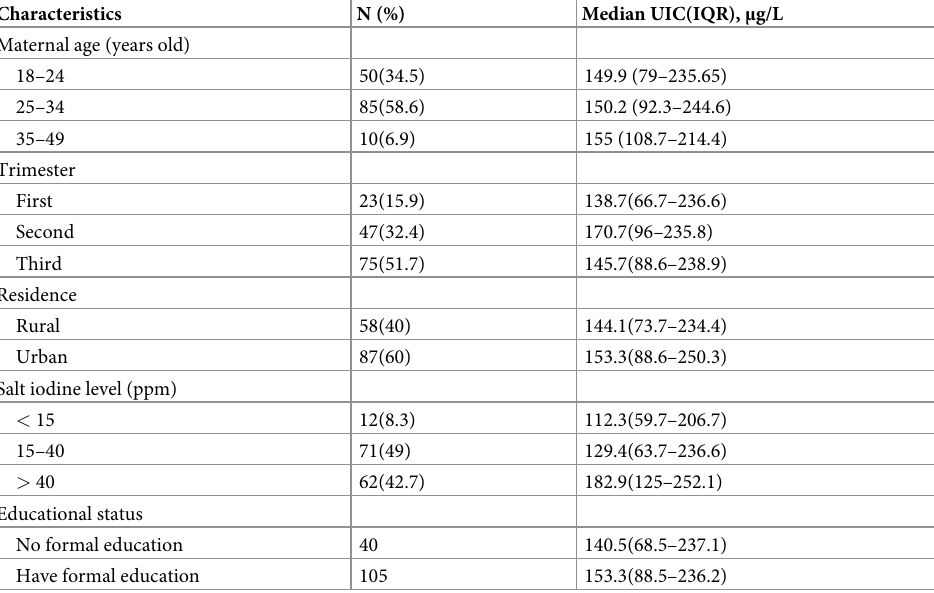
Table 3. Median UIC of pregnant women (n = 145) according to age, trimester, salt iodine level, literacy level, and residence in BUNMAP cohort study, Butajira, Ethiopia, February, 2019.